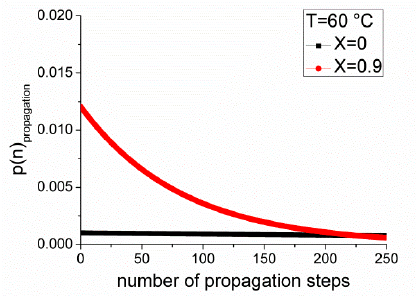
Figure 4. Comparison of instantaneous chain length distribution with distribution of number of radical migration steps at varying points of solution polymerization of butyl acrylate ([ M ] 0 = 3.9 M ) at 60 °C, 100 °C and 140 °C. It can be seen from Figure 4 that at low reaction temperatures and where monomer concentration is high (low conversion), the migration of the mid-chain radical is not expected to occur significantly, and therefore only short chain branches will be present. At higher temperatures, radical migration is faster relative to propagation from the mid-chain center due to the high activation energy of H transfer reactions relative to propagation. Similarly, at low monomer concentrations, the relative rate of migration to propagation is increased, resulting in a number of migration steps before reaction. It is interesting to note that at high temperatures and low monomer concentrations, the kinetic chain length of the polymer is also lower due to the increase in transfer and β -scission reactions at higher temperatures. In this case, it is feasible that the mid-chain radical will be randomly distributed along the chains rather than close to the end. Thus, while under most reaction conditions radical migration does not occur fast enough to compete with propagation (or β -scission) of the mid-chain center, reactions which are conducted under low monomer conditions, such as semibatch polymerizations, which are commonly performed